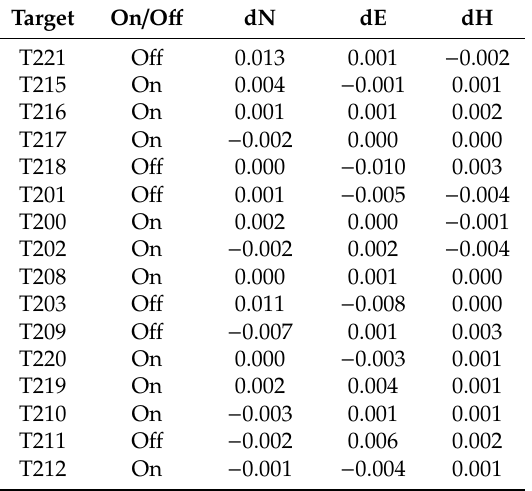
Table 4. Absolute orientation residuals on targets, values in